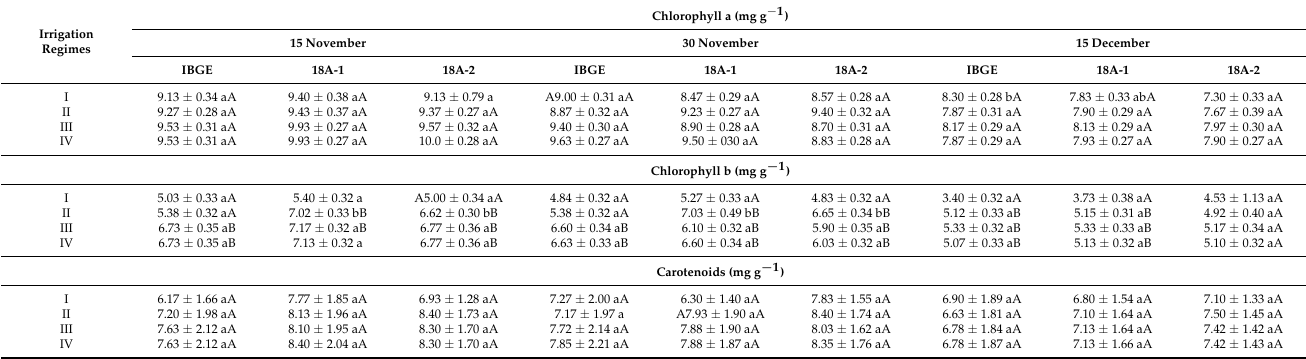
Values are means of six replicates from two growth cycles followed by standard errors of means ( n = 6). In each panel, bars under each irrigation regime with different lowercase letters show significant differences between wheat cultivars, and bars of each cultivar with different uppercase letters show significant differences between irrigation regimes at p < 0.05. I—irrigation at tillering stage; II—irrigations at tillering and booting stages; III—irrigations at tillering, booting, and flowering stages; IV—irrigations at tillering, booting, flowering, and grain filling